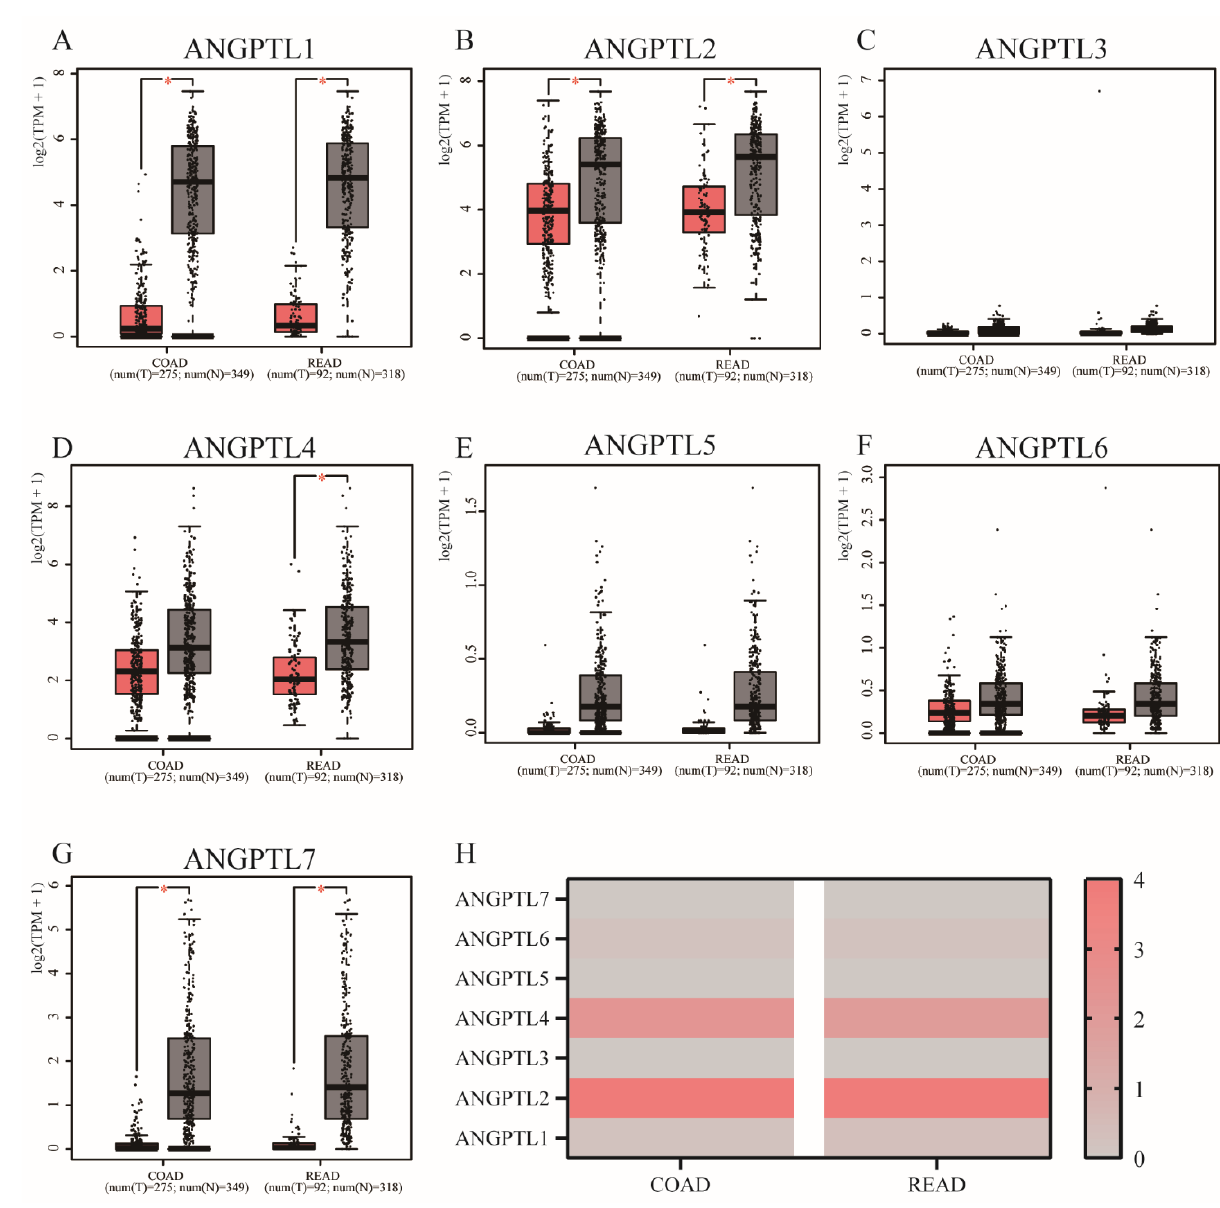
Figure 1. The mRNA expression levels of ANGPTLs in patients with colon cancer and rectal cancer (GEPIA2). ( A – G ) mRNA expression levels of seven ANGPTLs in colon/rectal cancer patients and normal tissues. T: colon/rectal cancer patient tissues; N: normal tissues. ( H ) The relative expression of seven ANGPTLs in colon/rectal cancer patients. * p < 0.05.